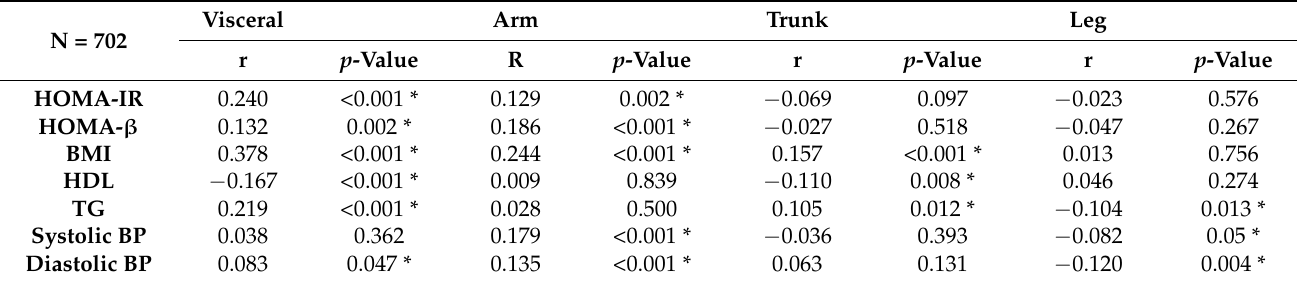
Table 5. Associations between regional adiposity and metabolic characteristics in